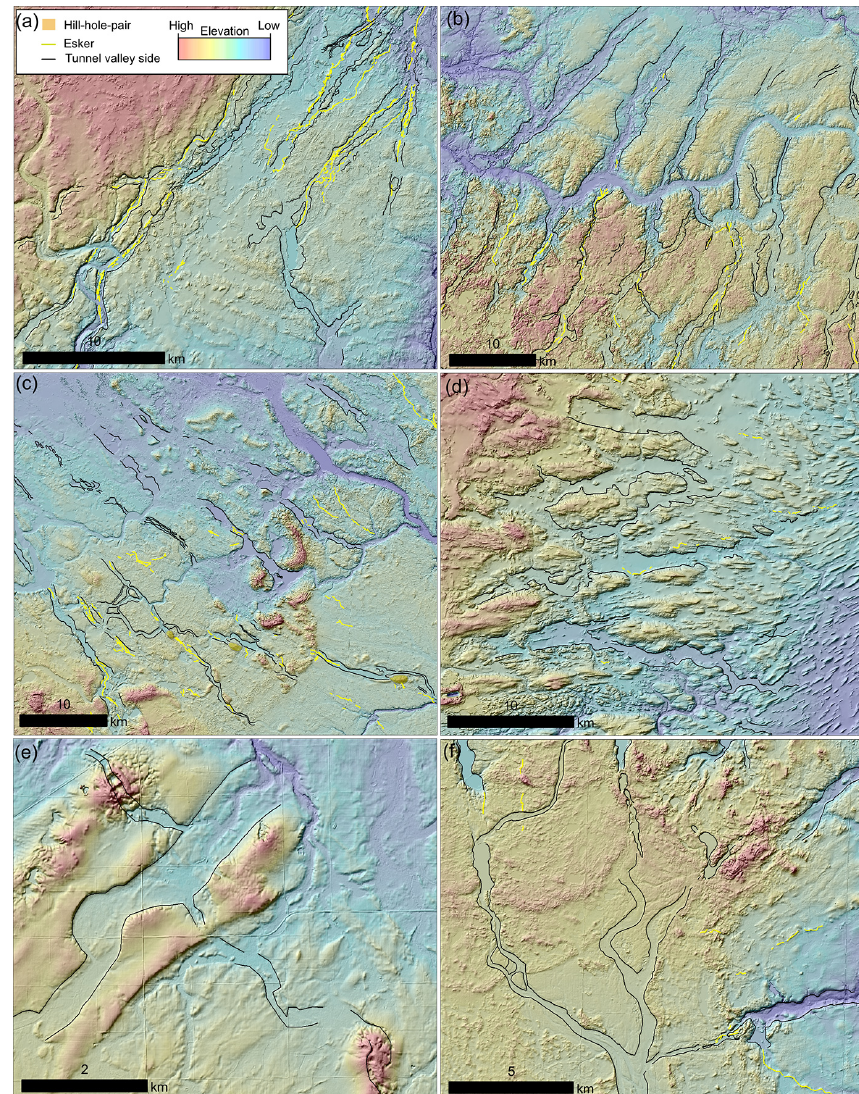
Figure 3. Examples of mapped valleys and the assignment of confidence levels (1 = high confidence to 3 = low confidence) along the southern sector of the former Laurentide Ice Sheet. Valleys in panels (a) Superior, (b) Saginaw, (c) North Dakota and (d) Green Bay are assigned a confidence of 1. The relict valleys contain eskers, are parallel and relatively straight, and do not trend along the regional slope. In panels (a) , (c) and (d) the tunnel valley clusters terminate at a moraine position. The large valley in panel (e) (Superior) is assigned a confidence level of 3 as it does not contain any subglacial bedforms and exhibits a gradual and consistent change in bed slope consistent with a proglacial spillway. However, the smaller NW-SE valleys that it bisects is given a confidence of 2 as they have undulating thalwegs that cut across moraines. The dendritic valley cluster in panel (f) (North Dakota) is given a confidence of 3 as it is not associated with any subglacial bedforms and has a consistent bed slope indicating water flow towards the south. A braided channel morphology and a widening reach towards the south allows us to interpret this valley system as a proglacial spillway (fed by tunnel valleys emanating from under the ice to the